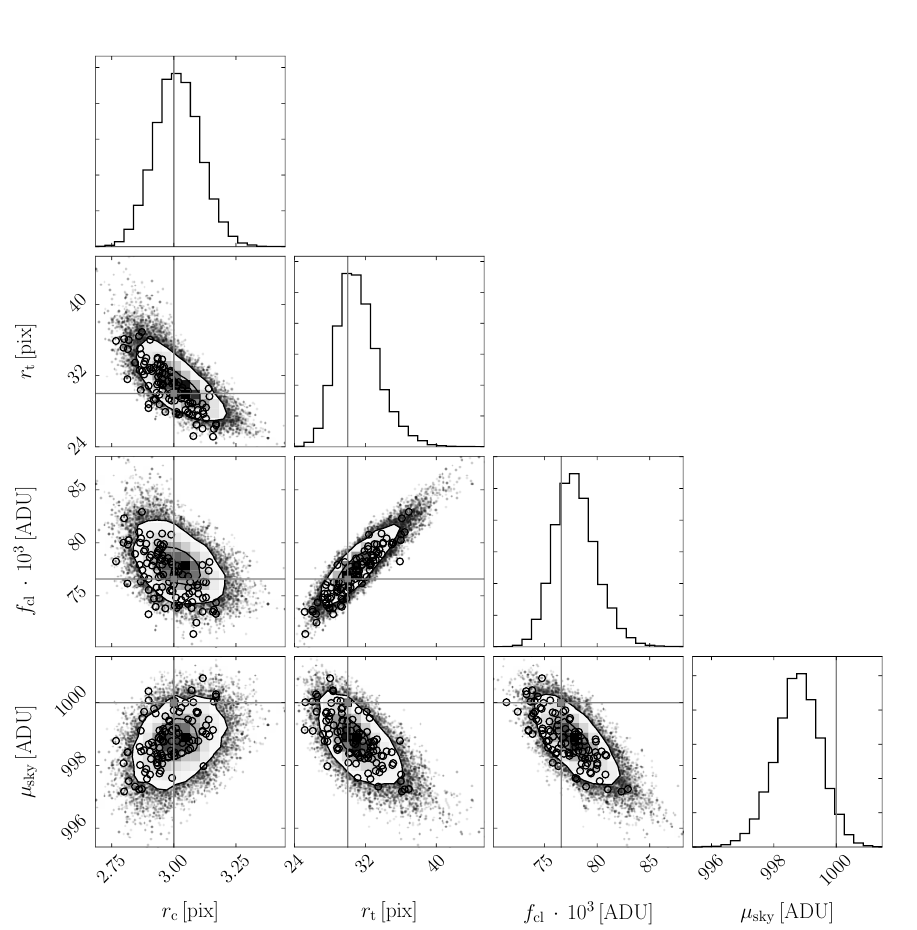
Fig. 4. Same as in Fig. 2, but for S/N = 100. Note the shorter range of axis